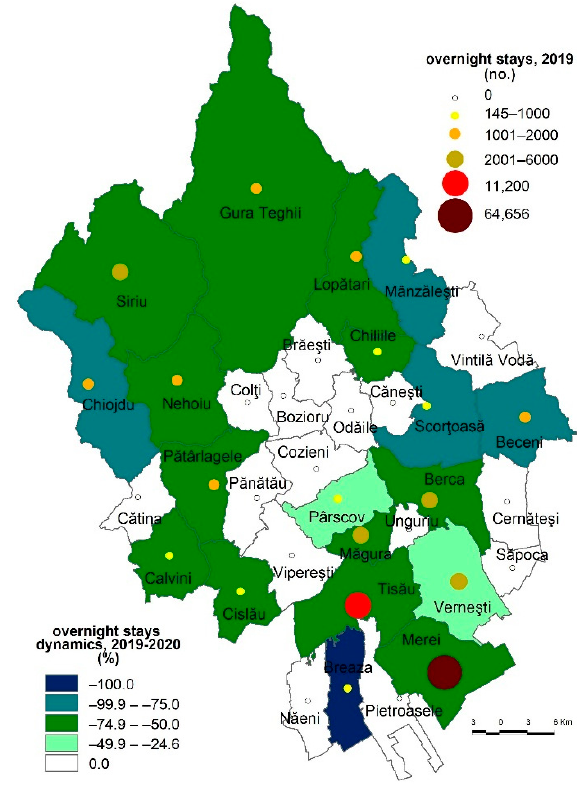
Figure 5. The dynamics of overnight stays, 2019–2020.